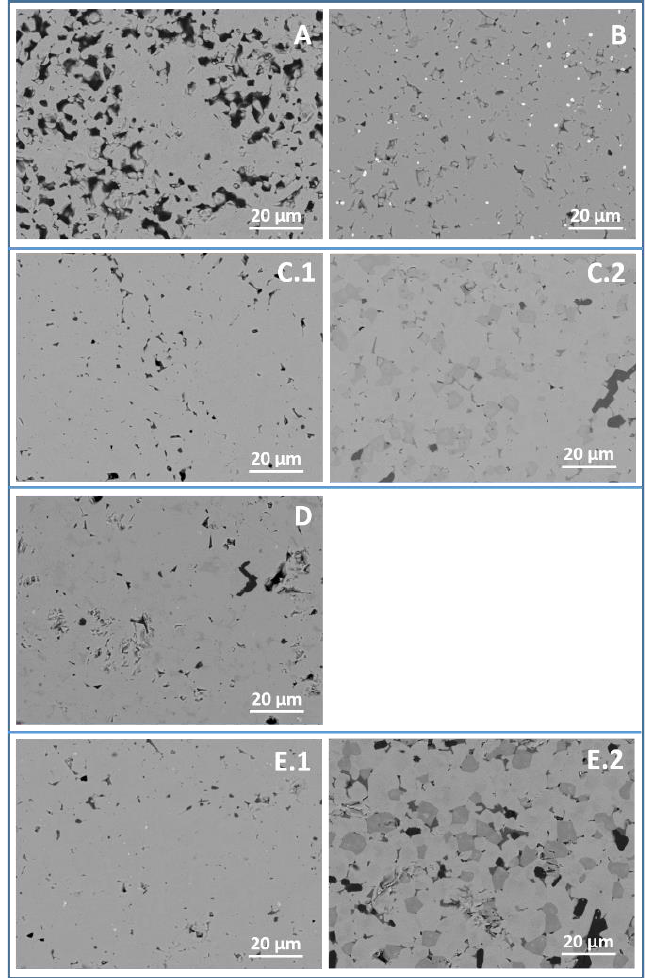
Figure 2. SEM micrographs of HIPed samples (A – E) prepared with different milling parameters at 400 rpm. Two areas are displayed for Samples C and E, labelled as C.1 and C.2 respectively.